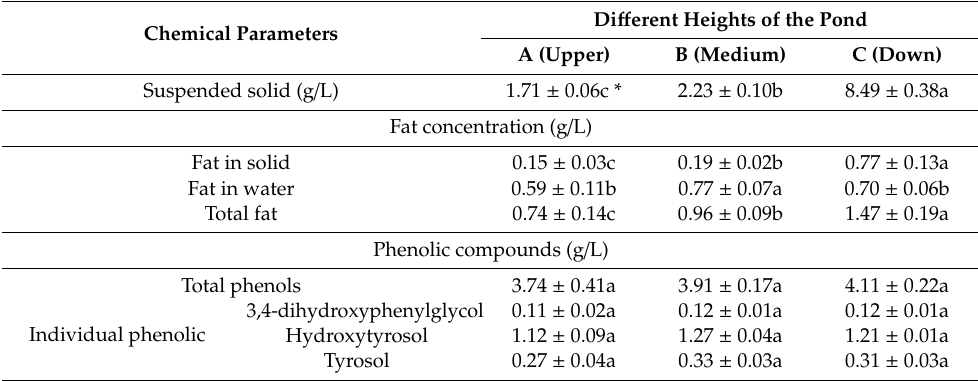
Table 1. Chemical parameters, suspended solid, fat and phenolics of the alperujo water collected from three di ff erent heights of the pond, upper (A), medium (B) and down